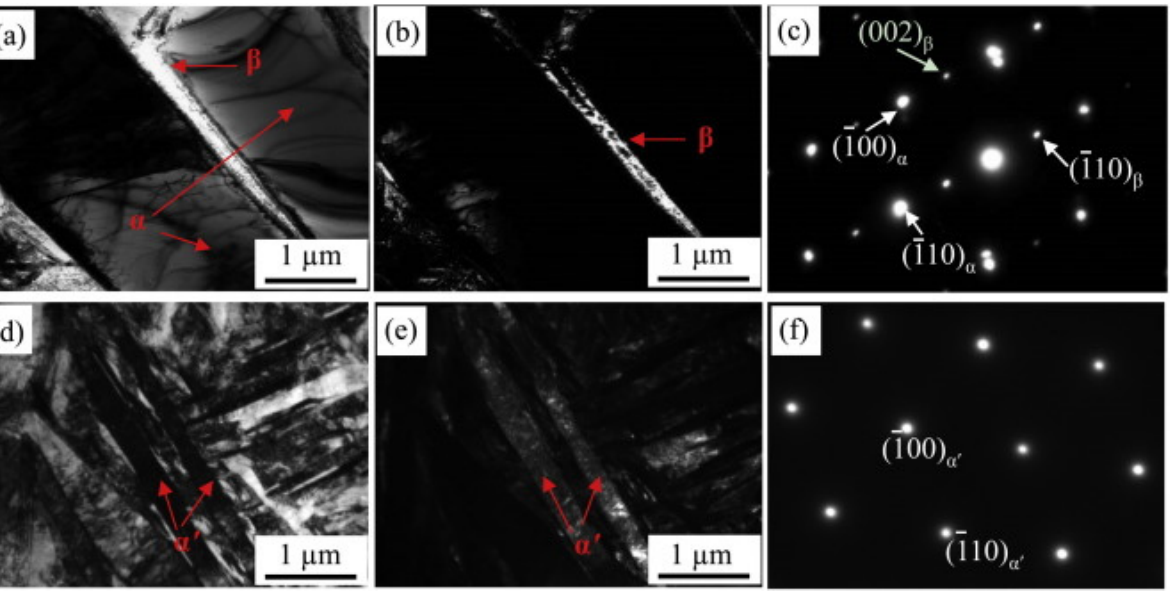
Figure 2. TEM images of Ti6Al4V produced by Electron Beam Melting ( a – c ) and LPBF ( d – f ): ( a , d ) bright-field images; ( b , e ) dark-field images; ( c , f ) diffraction patterns (reproduced with permission from [38]. Copyright 2016 Elsevier).